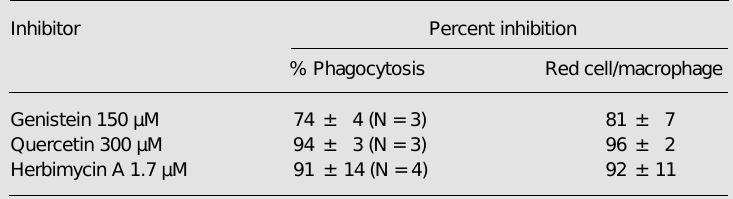
Macrophages activated in vivo with LPS were preincubated at 37 (cid:1) C for 10 min with tyrosine kinase inhibitors. Phagocytosis assays were performed in the presence of the inhibitors. Results are reported as percent inhibition relative to the control for each cell preparation (paired experiments), and calculated as follows: percent inhibition = 100 x (control - test)/control. Data are reported as means ± SD of 3 to 4 experiments (different